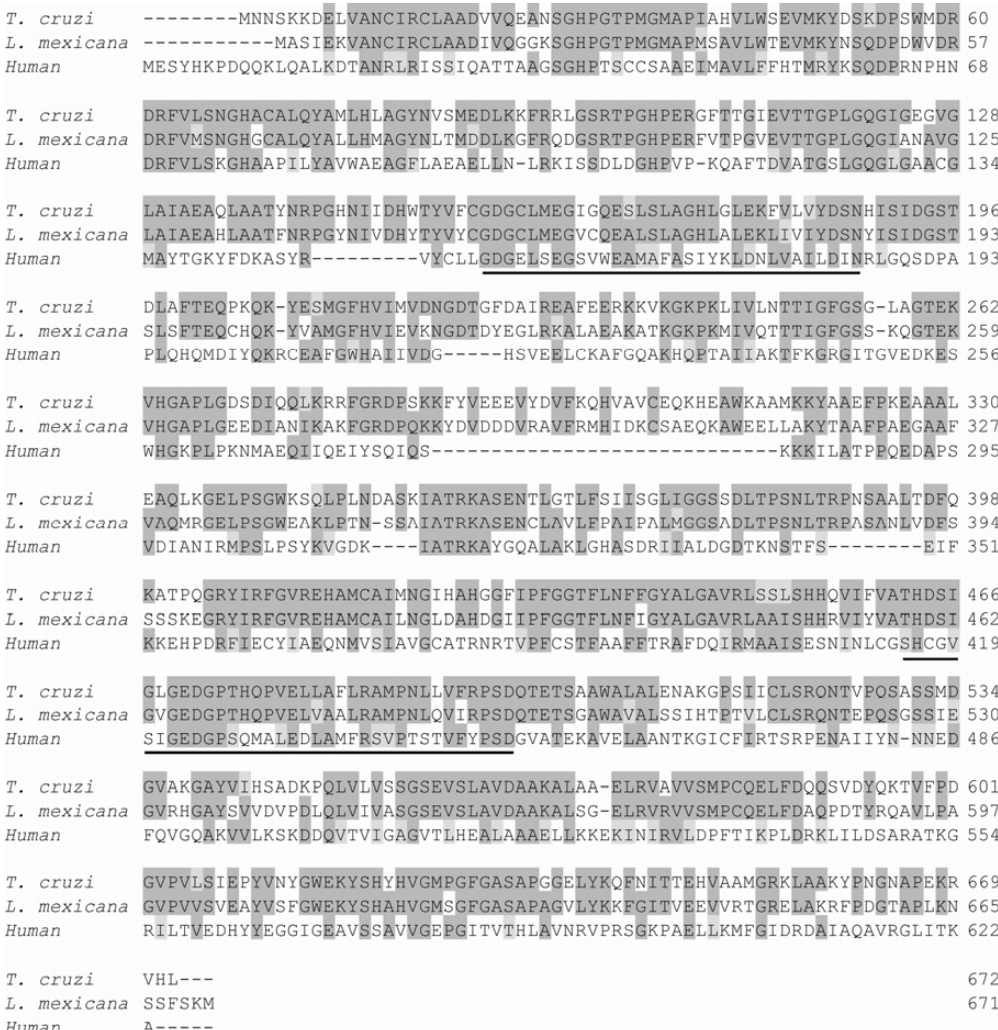
Fig. 9 – Alignment of the deduced amino acid sequences of different transketolases. The accession numbers for the sequences aligned using the Clustal program are the following: T. cruzi EU077555, L. mexicana Aj427448, human P29401. Boxes shaded in dark grey show correspond to identical residues. The conserved TKT and ThDP boxes, which are involved in cofactor and substrate union, are